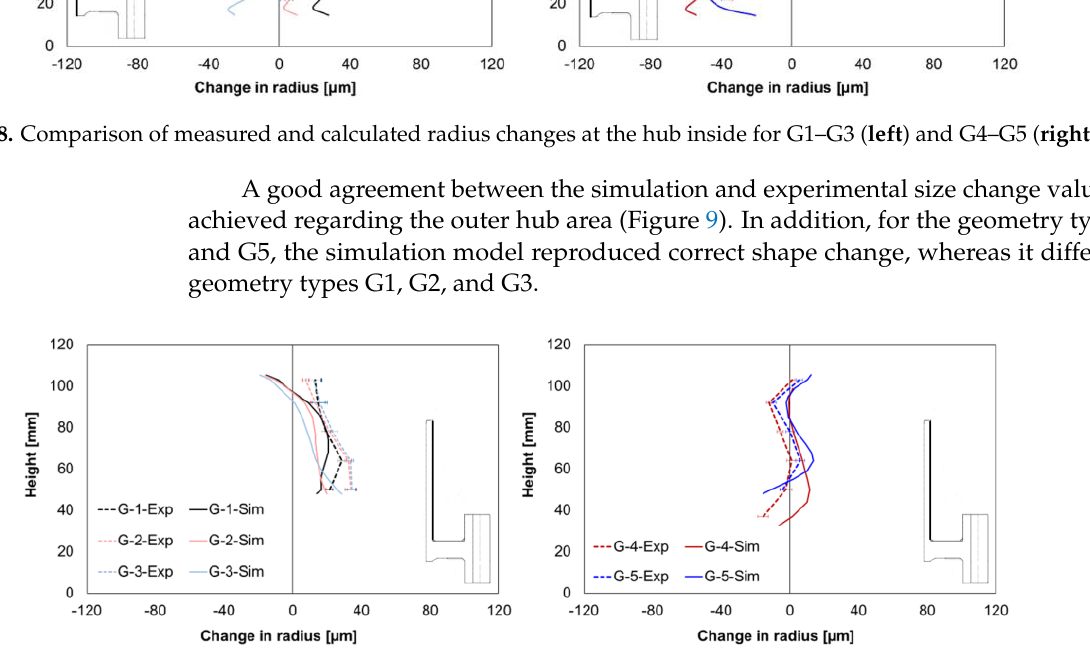
Figure 9. Comparison of the measured and calculated radius changes at the hub outside for G1– G3 ( left ) and G4–G5 ( right ).